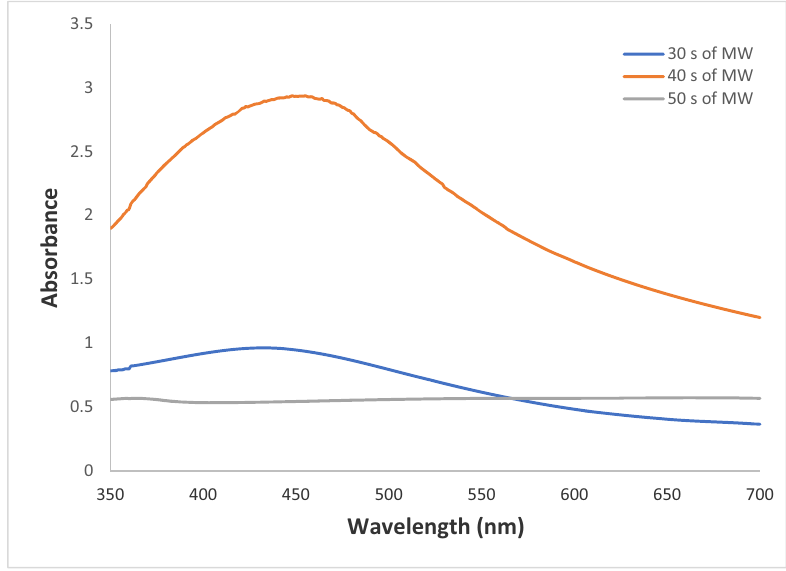
Figure 5: UV – Vis spectra of synthesized AgNPs with 2.5 g · L − 1 of AgNO 3 at di ff erent varying time of microwave exposure.